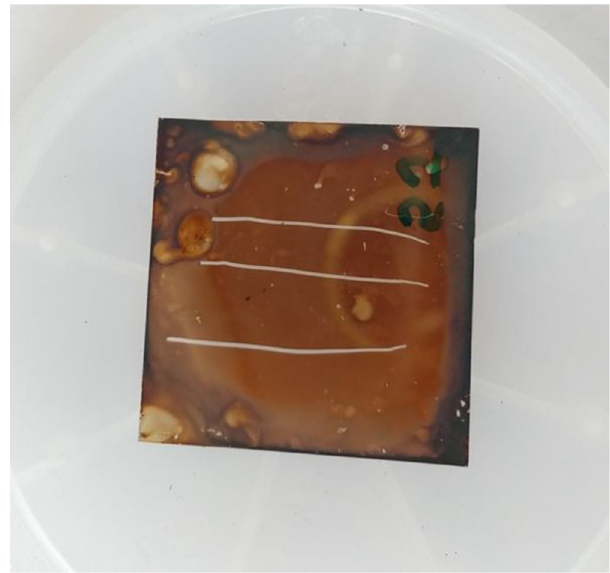
Fig. 3. Ultrasonically spray coated perovskite sample after undergoing vacuum quenching for accelerated crystallization. Stripes were made for the purpose of thickness measurements.